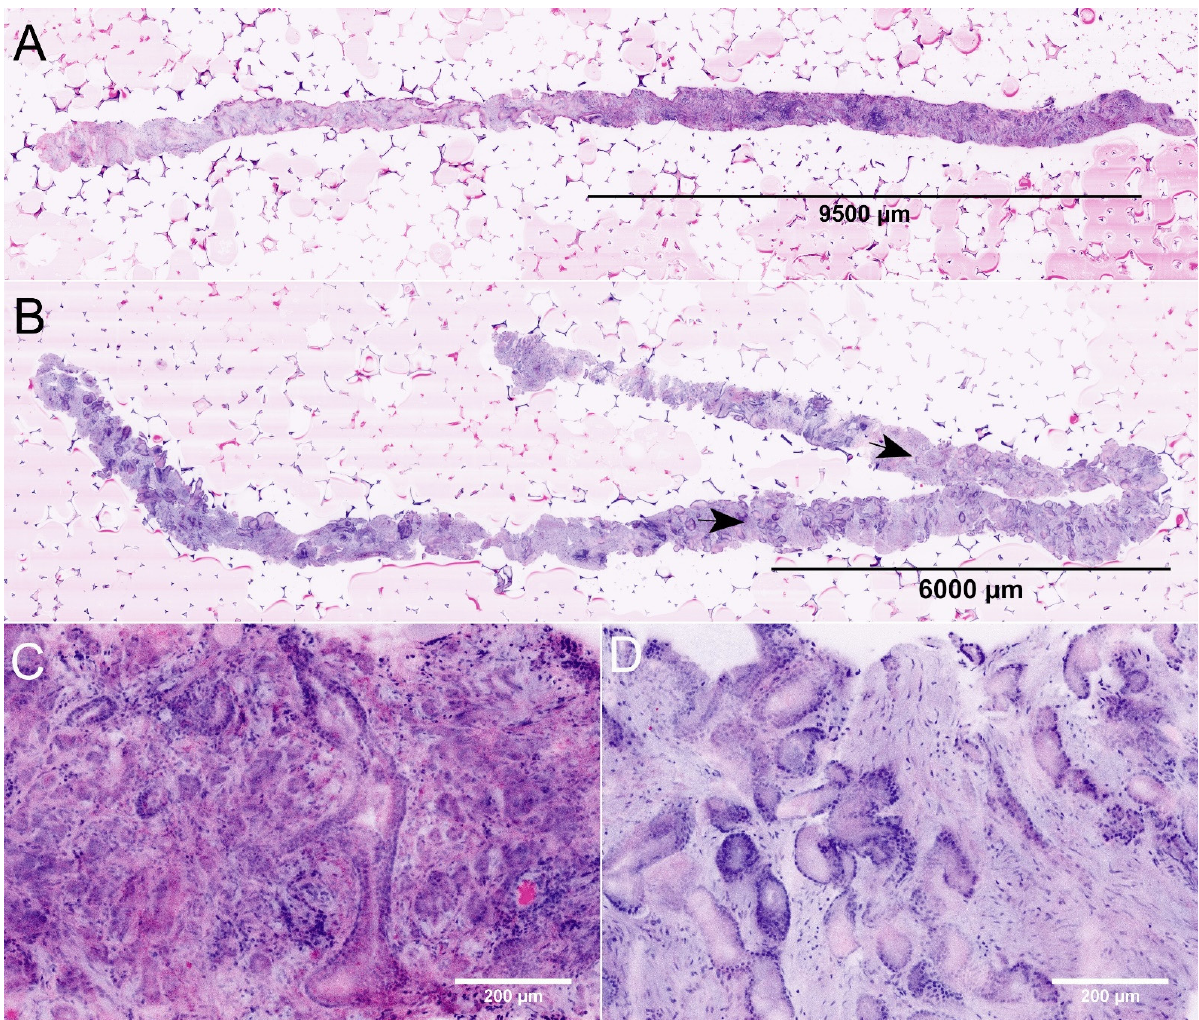
Figure 1. FCM images of MRI-guided biopsies of the prostate. ( A ) + ( C ): Full Scan ( A ) and detail ( C ) of an MRI-targeted biopsy from a PI-RADS-5 lesion (P22). The images show the biopsy of 19.8 mm length carrying carcinoma (lesion size 9.6 mm, infiltration grade 48%). The tumor focally shows patterns of poorly formed and fused glands (GLEASON-pattern 4). The intraoperative diagnosis was ISUP grade 2 carcinoma indicating a tumor disease requiring intervention. ( B ) + ( D ): Full scan ( B ) and detail ( D ) of an MRI-targeted biopsy from another PI-RADS-5 lesion (P31). This biopsy of 27.4 mm length contains a tumor infiltrate of 9.3 mm size (arrows, infiltration grade 34%). The tumor was consistently composed of well differentiated glands (GLEASON-pattern 3). The intraoperative diagnosis was ISUP grade 1 carcinoma. To date, the patient remains in active surveillance. 2.3. Analysis of Clinically Relevant Carcinoma Infiltrates in the Biopsies The definition of clinically relevant PCa is not consistent in existing published stud- ies. Based on autopsy studies, ISUP grade 1 tumors with foci sizes > 0.5 mL were defined as clinically significant for RPE preparations [26]. According to 3D reconstruction studies, this corresponds to a focal size of 6 mm in needle biopsies [27]. Consistent with a large validation study, tumors with ISUP grade 2 or focal sizes > 6mm were defined as clinically relevant for this study [28]. Each tumor-bearing biopsy was assigned as to whether it was a clinically relevant lesion based on the above definition. The frequencies of clinically rel- evant tumor foci in the targeted and systematic biopsies were compared.